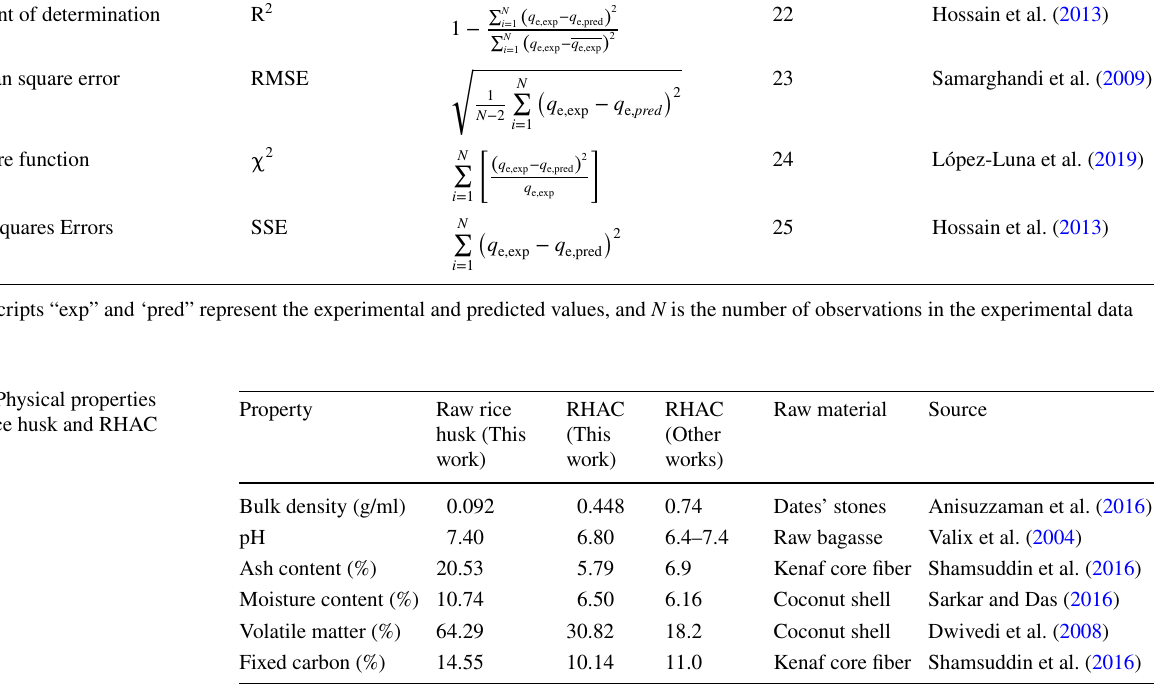
Table 2 The mathematical expressions of the error functions